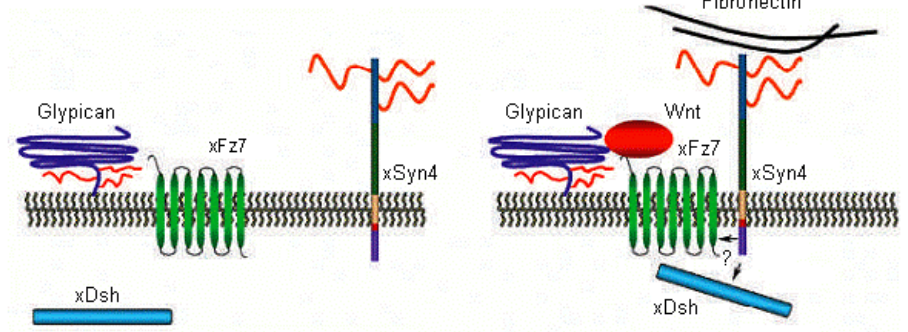
FIGURE 2. Schematic representation of the proposed role of xSyn4 in noncanonical Wnt